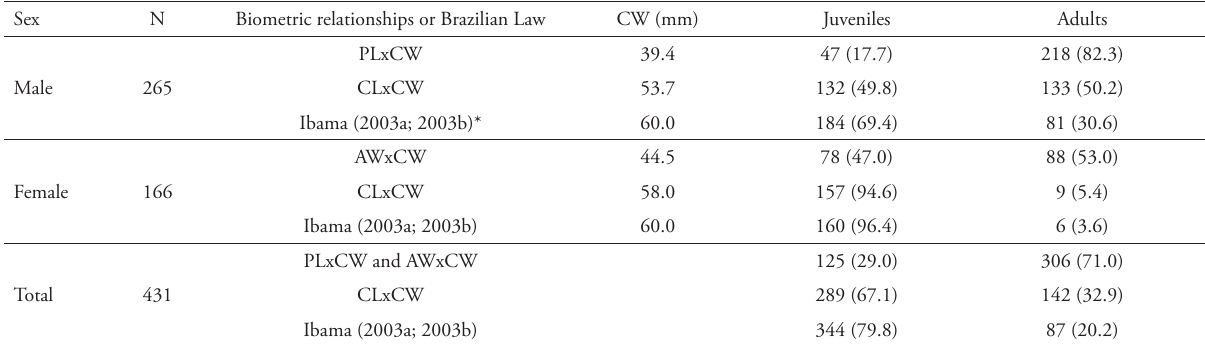
Table 4 . Ucides cordatus (Linnaeus, 1763). Number of individuals (percent within parentheses) in each developmental phase (juvenile and adult) and maturity size estimated by the biometric relationships in comparison with minimum capture size by Brazilian laws. AW represents the abdominal width of 5 th somite, CW is the carapace width, and PL is the propodus length of major